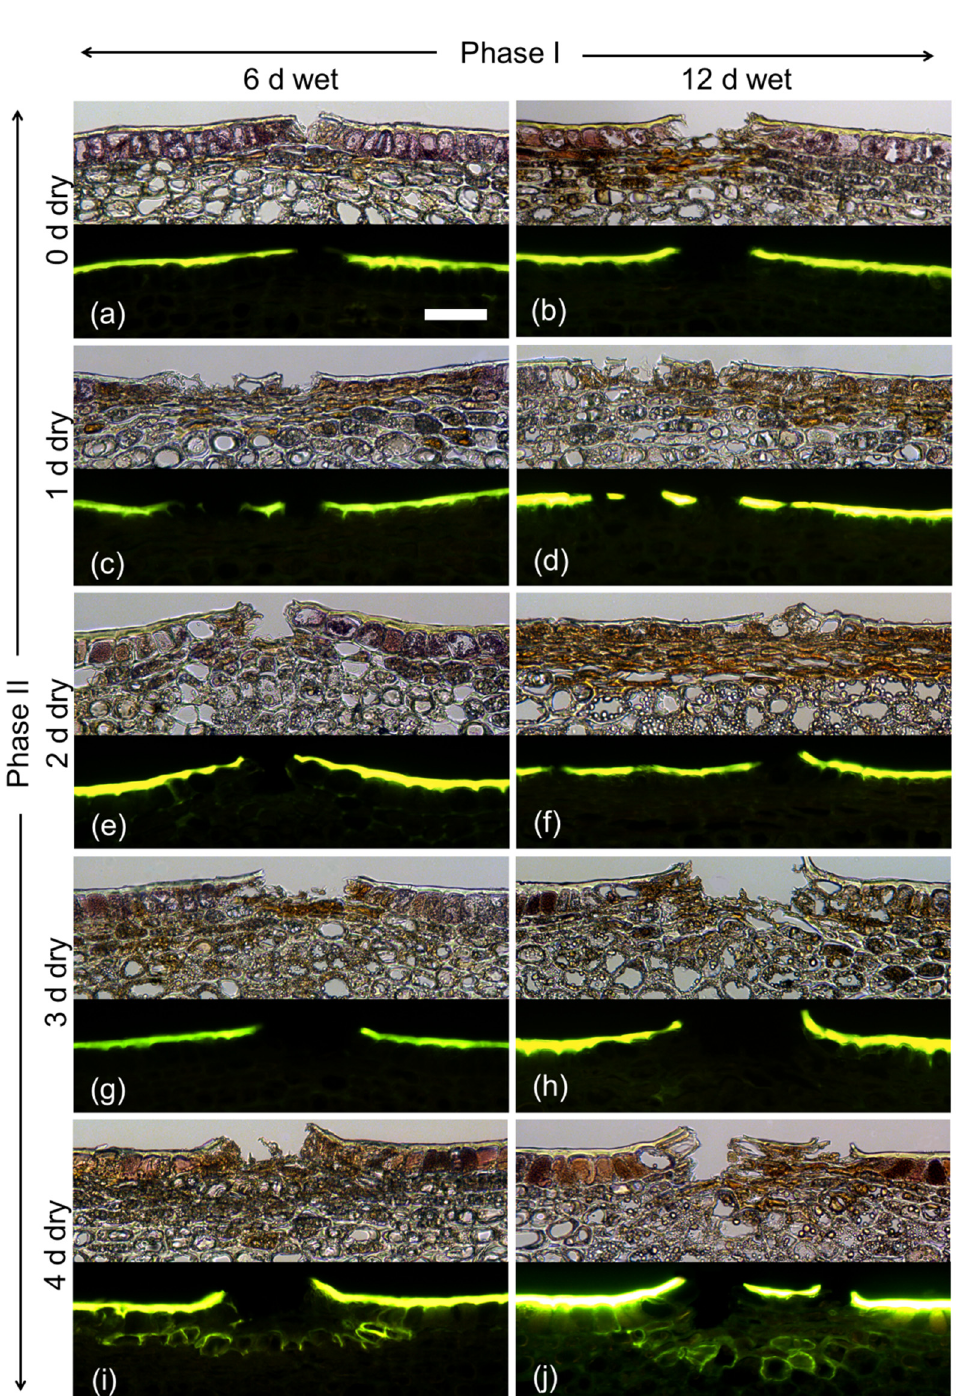
Figure 3. Effect of moisture exposure for 6 d ( a , c , e , g , i ) or for 12 d ( b , d , f , h , j ) on the time course of periderm development established at 0 d ( a , b ), 1 d ( c , d ), 2 d ( e , f ), 3 d ( g , h ) or 4 d ( i , j ) after termination of moisture exposure. The experiment comprised two phases: Phase I of moisture exposure and Phase II after termination of moisture exposure. Micrographs taken under transmitted white light (upper) or incident fluorescent light (lower) (filter module U-MWB) following staining with Fluorol Yellow 088. The scale bar in ( a ) is 50 µm long and representative of all images in the composite ( n = 3).